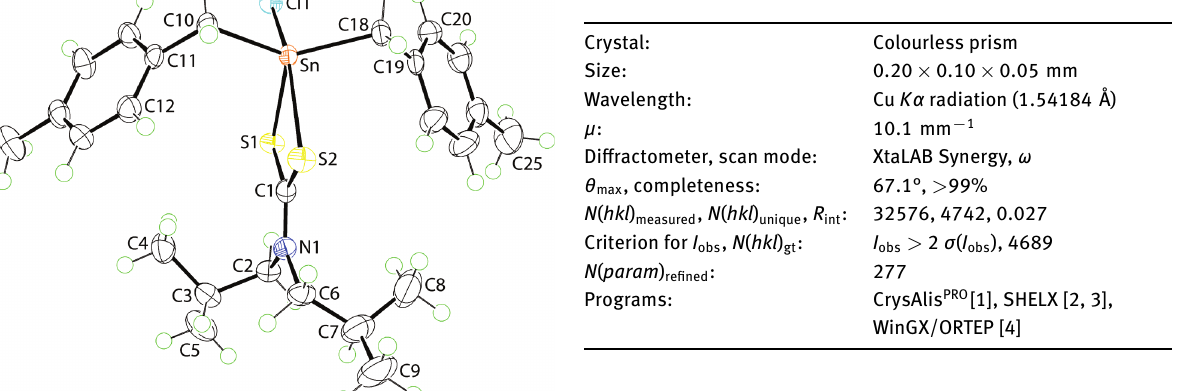
Table 1: Data collection and handling.